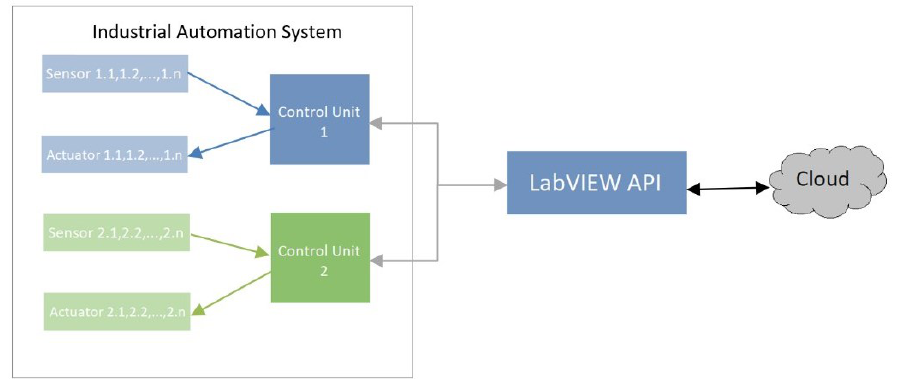
Figure 6. System interface using